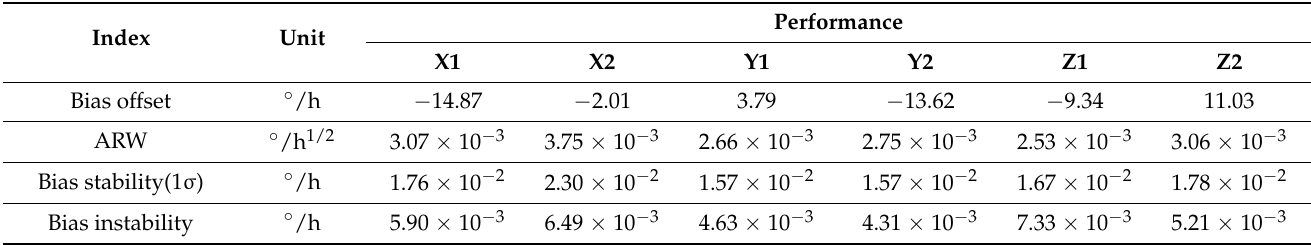
Table 2. Ground test results of the IMU 4 months later.